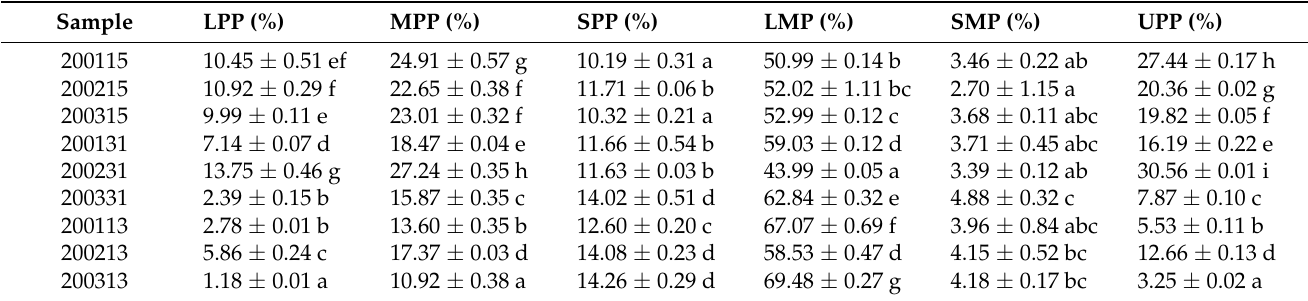
Table 2. Relative content of different protein fractions in the recombinant